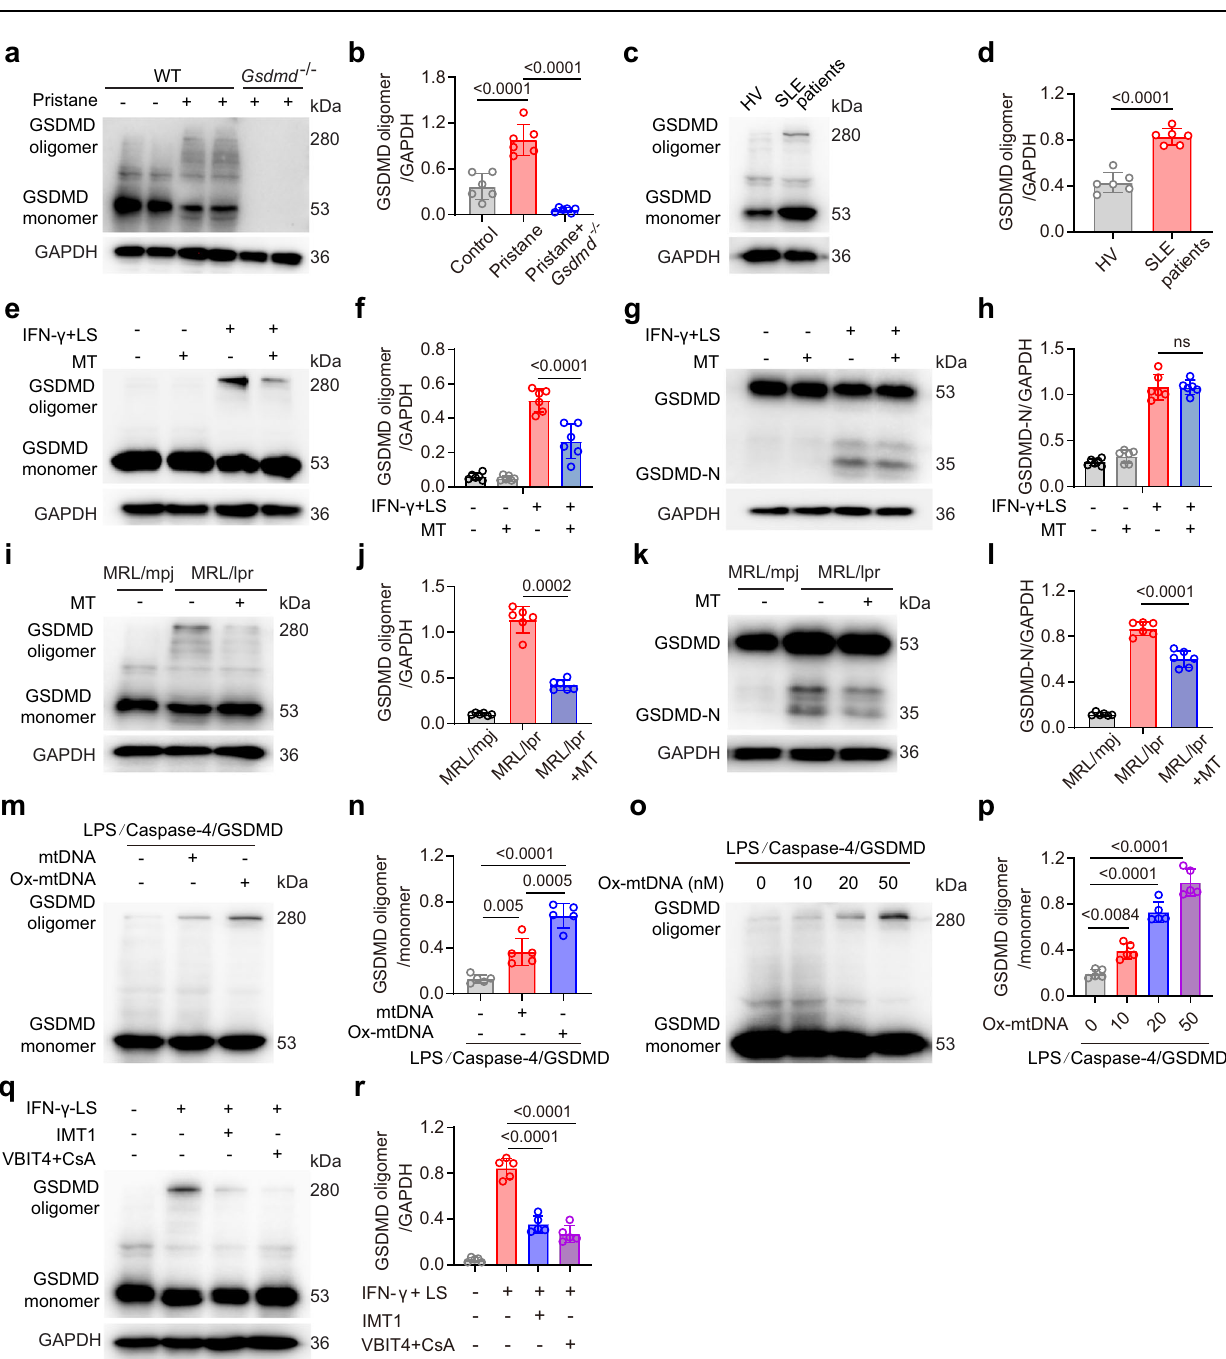
protein and LPS in vitro, then added with human mtDNA or Ox-mtDNA (20nM). n Quantitative analysis of GSDMD oligomer/GSDMD monomer. o Non-reducing immunoblotting of GSDMD oligomer. The LPS/caspase-4/GSDMD system was added with Ox-mtDNA at 0, 10, 20 and 50nM. p Quantitative analysis of GSDMD oligomer/GSDMD monomer. q Non-reducing immunoblotting of GSDMD oligo- mer.MurineBMneutrophilswerepretreatedwithIMT1orCsAplusVBTI4andthen treatedwithIFN- γ plusLS. r QuantitativeanalysisofGSDMDoligomer/GAPDH.n=5 ( r ) or 6 mice ( b , d , f , h , j , l ). Plots were pooled from fi ve independent experiments (n, p). The immunoblotting samples shown are from the same experiment. Three blots were processed in parallel ( b , d , f , h , j , i , r ). Data are presented as mean±SD. Signi fi cancewasexaminedwithone-wayANOVA( b , f , h , j , l , n , p , r )orunpairedtwo- sided Student ’ s t test ( d